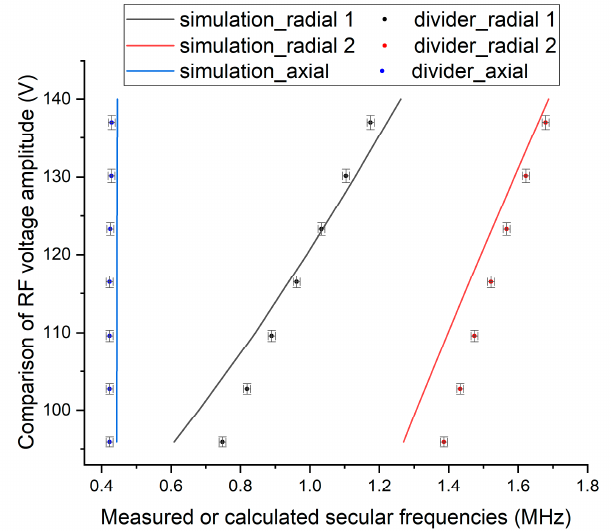
Figure 10. Relation between measured secular frequencies and RF voltage amplitude measured by the proposed voltage divider. The uncertainty of the measured RF voltage amplitude is 0.659% .